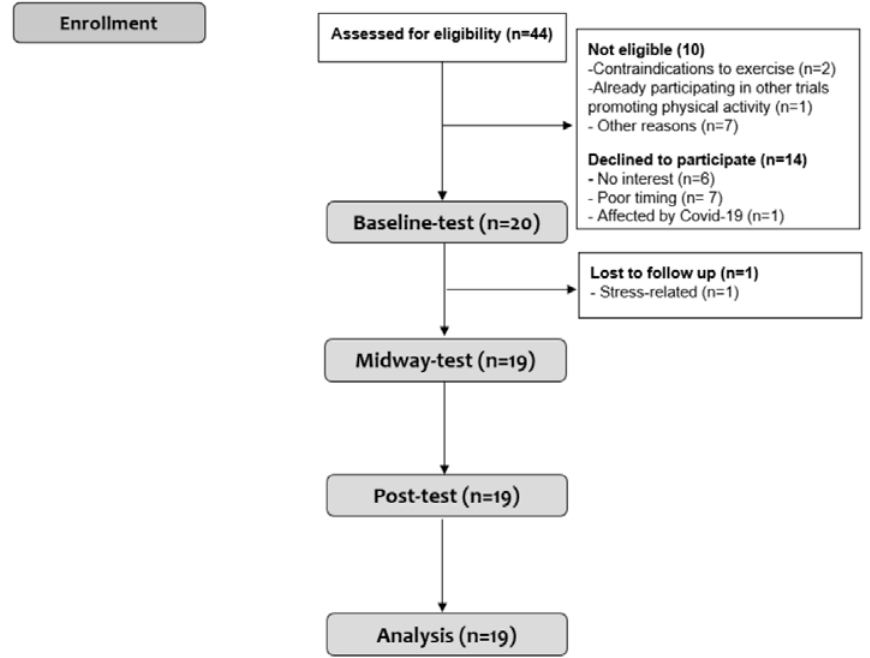
Figure 2. Flowchart of participant enrolment, follow-up, and analysis. Other reasons for declining to participate were stress and other mental disorders ( n = 3), personal reasons ( n = 1), residing abroad ( n = 1), and loss of spouse ( n = 1). Table 2. Baseline characteristics of participants.